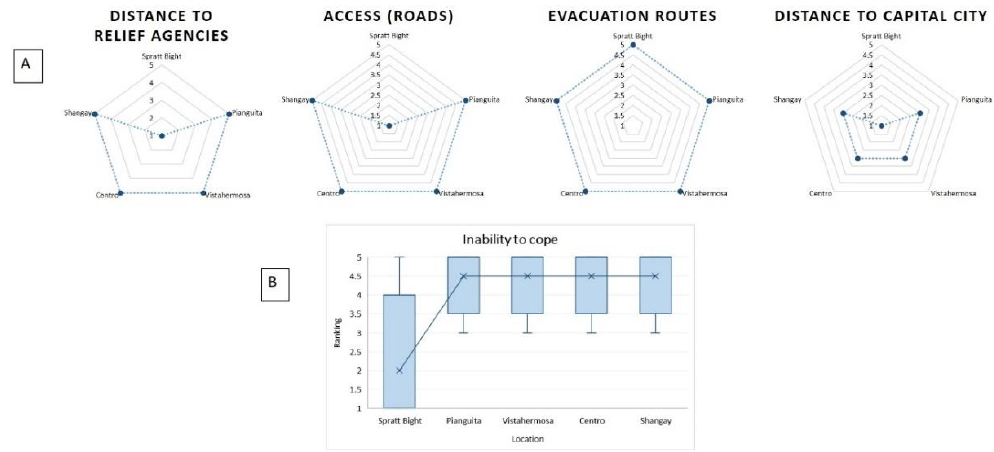
Figure 15. ( A ) Ranking of four variables representing inability to cope for two study areas (and five villages): San Andrés, Caribbean Coast (Spratt Bight) and La Bocana, Pacific Coast (Pianguita, Vistahermosa, Centro, Shangay) of Colombia. ( B ) Minimum and maximum values of inability to cope for each village and average rank. Results are shown by ranking, given that units of analysis are rank levels and not segments, as was the case for hazard.